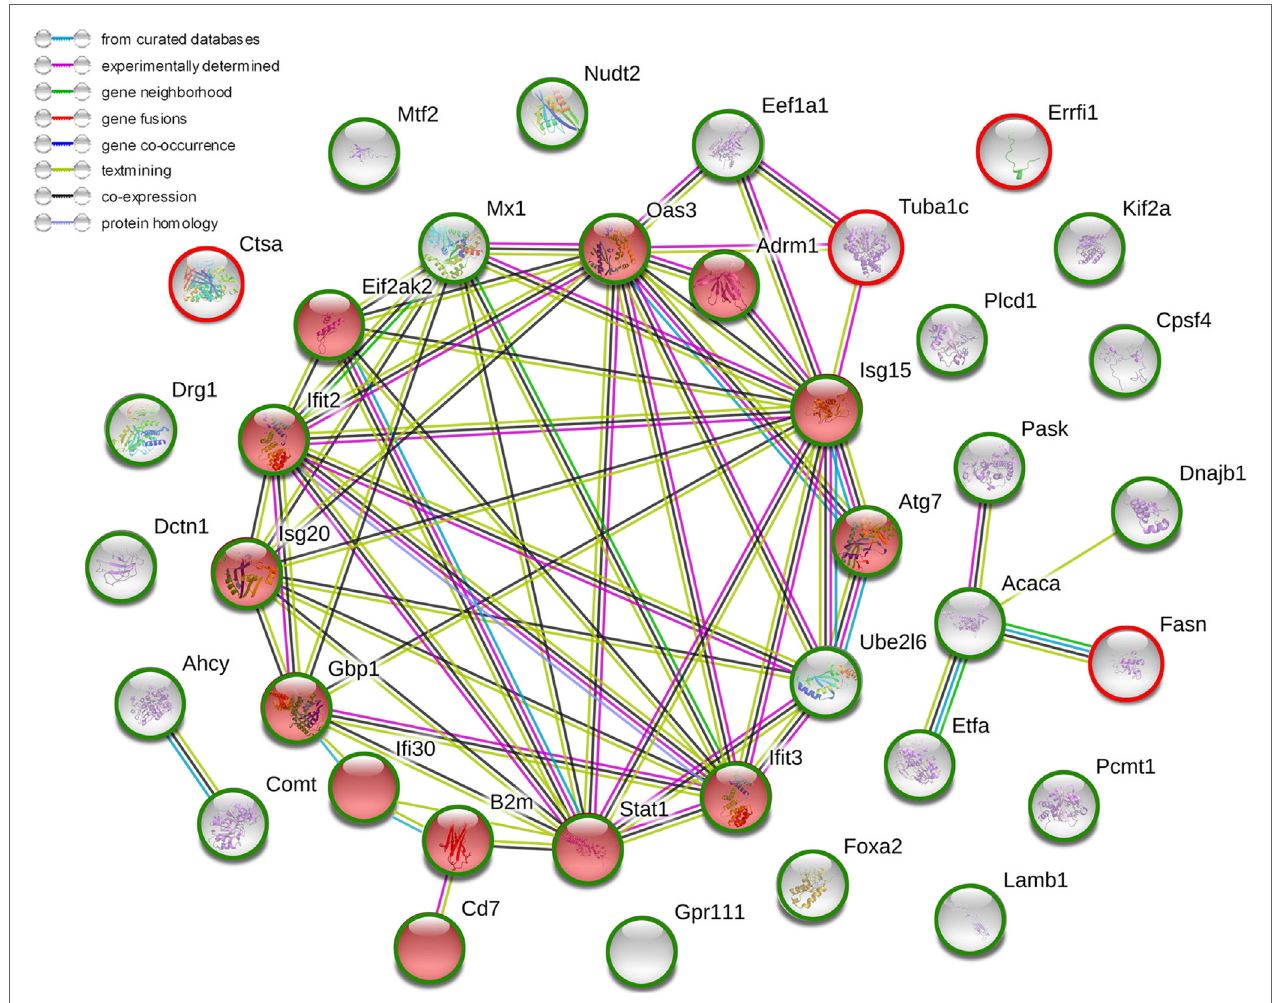
FigUre 7 | The current interactions of changed proteins in liver tissues with ARC pretreatment compared with those with vehicle pretreatment at 12 h after ConA administration. The red nodes represented the functional enrichments of proteins in immune system. The red circles represented upregulated proteins while the green circles represented downregulated proteins. The network was made on the basis of